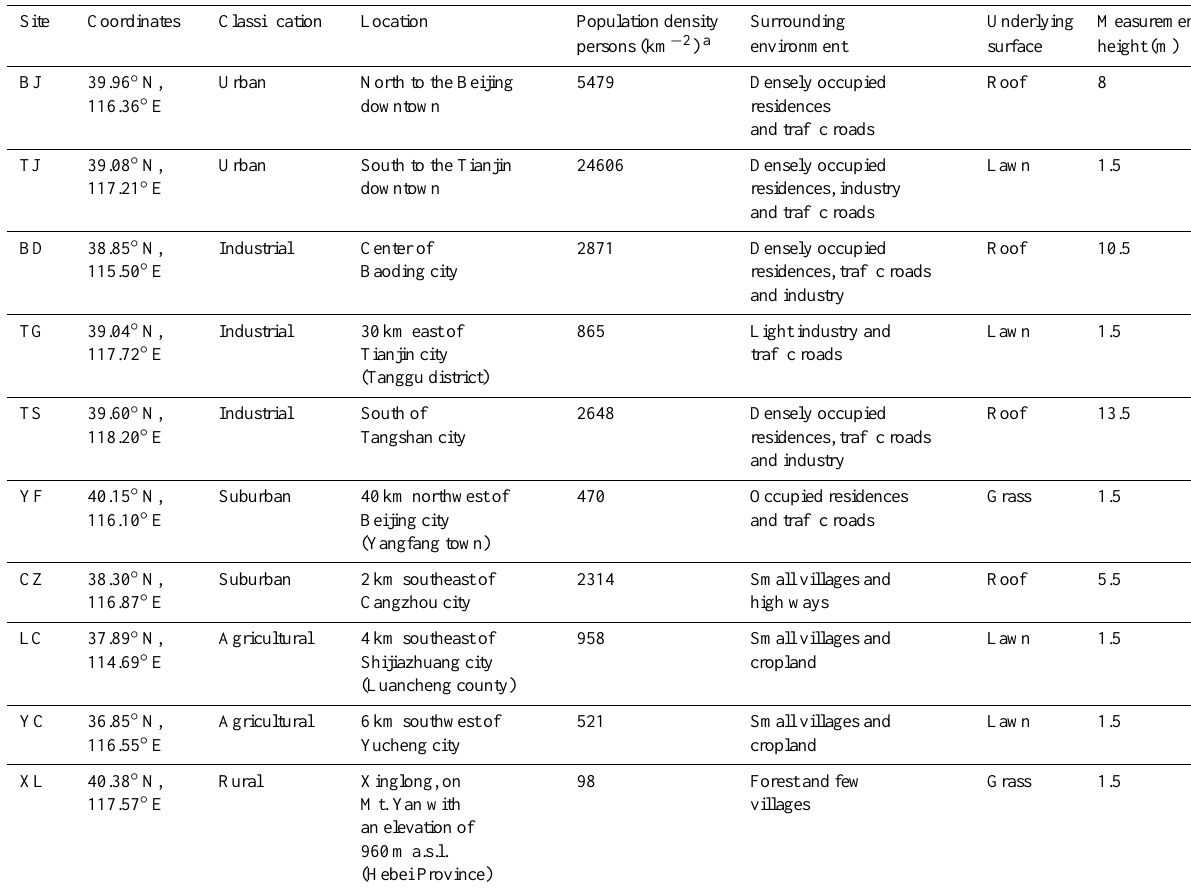
Table 1. Descriptions of the 10 sampling sites in the wet and dry deposition observation network of Northern China. Site